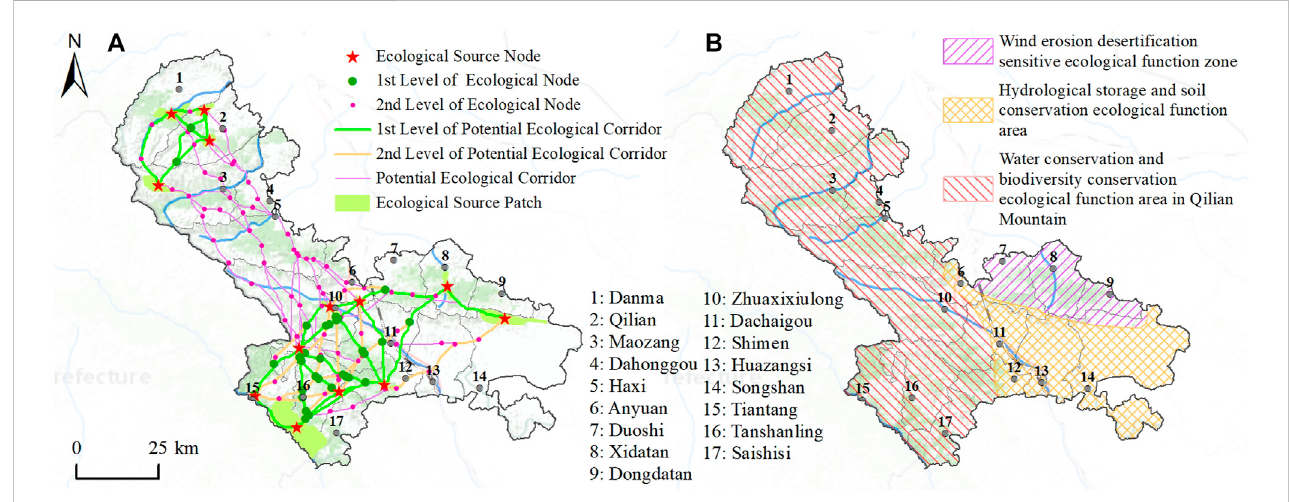
FIGURE 5 (A) Spatial distribution of eco-nodes and potential ecocorridors, (B) Optimization scheme of ecological